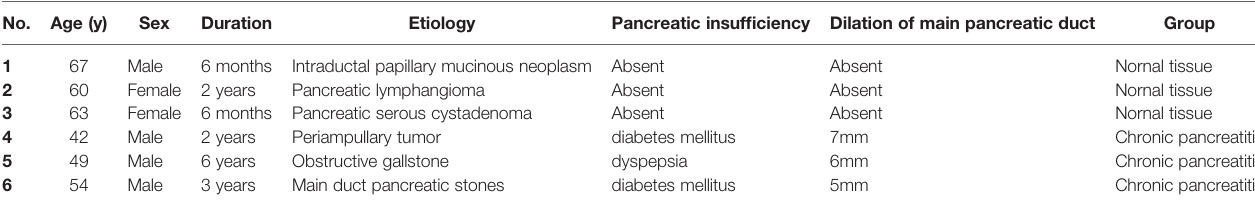
TABLE 1 | Clinical characteristics of human pancreatic